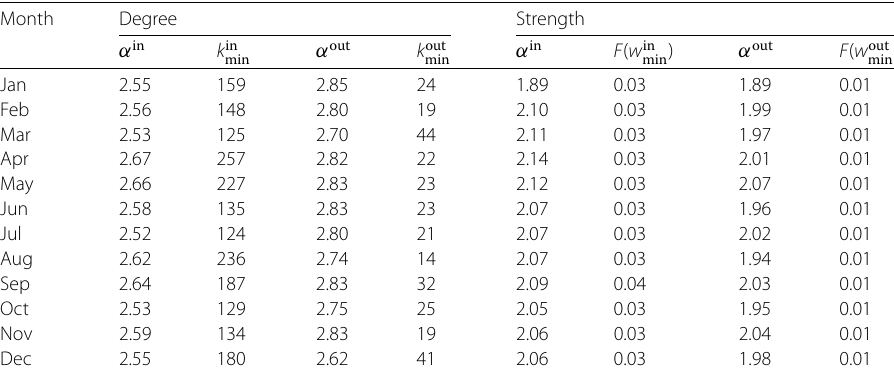
Table 7 Results of power law fit of the degree and strength distribution for all the months obtained by using the algorithm described in [47]. The α parameter is the fitted exponent and the k min and w min parameter is the estimated minimum value after which the behaviour of the distribution is consistent with a power law tail. Since the volume of payments are scaled, the values of w min s are not much informative, so for the strength F ( w min ) = 1 – ECDF ( w min ) is reported instead